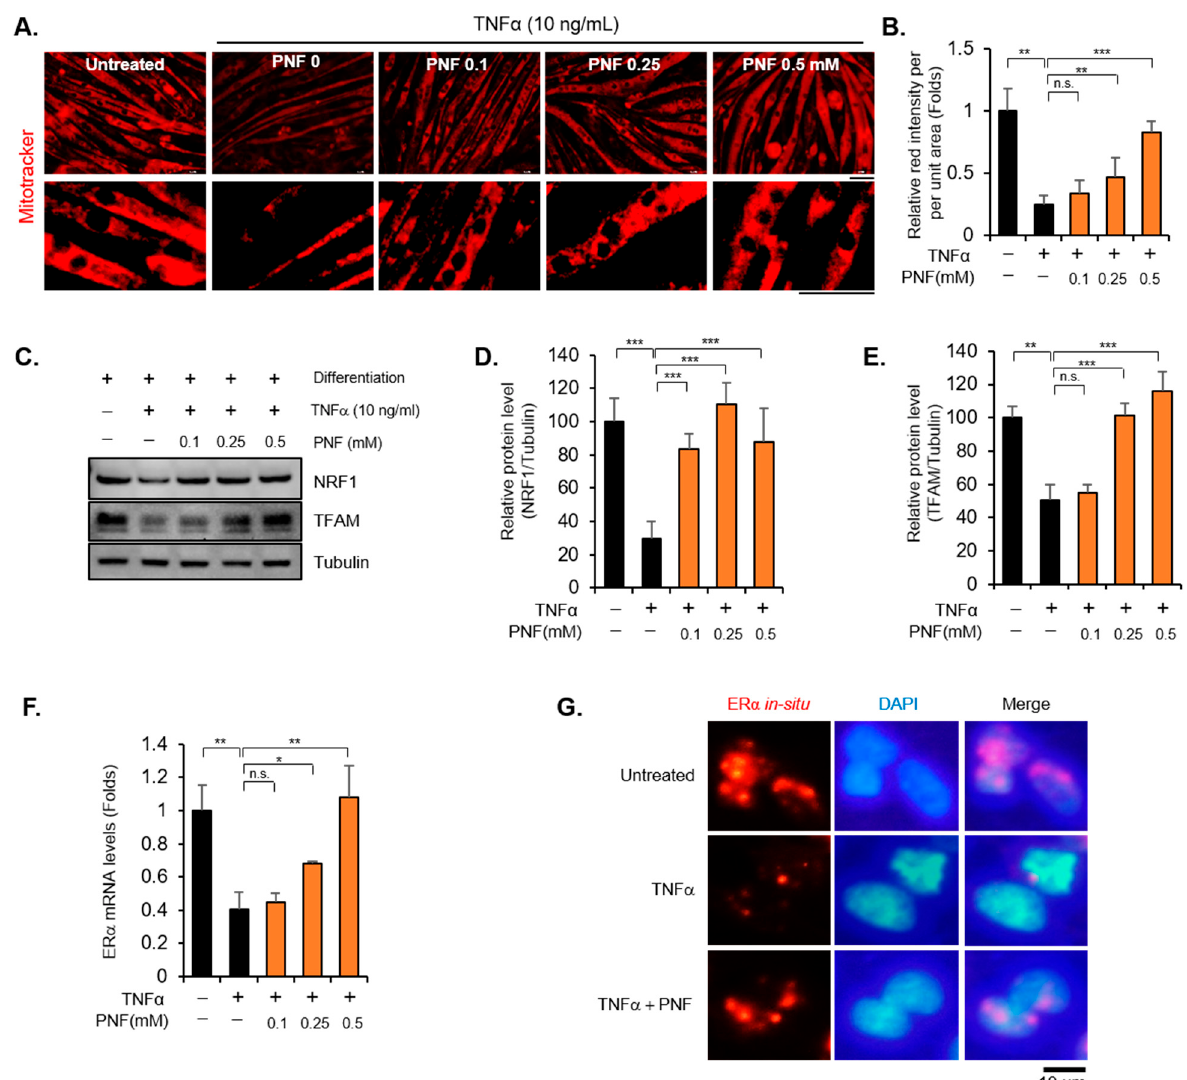
Figure 3. PNF restores mitochondrial biogenesis through NRF1, TFAM, and ER α in C2C12 cells: ( A ) Differentiated myoblasts were stained with MitoTracker. MitoTracker is shown in red. The scale bar indicates 50 µ m ( n = 5). ( B ) Intensity of MitoTracker was quantified in individual muscle cells ( n = 20 for each group). ( C ) Immunoblotting was performed on proteins extracted from differentiated muscle protein. Tubulin was used as an internal control. ( D , E ) Relative densitometric quantification of NRF1 and TFAM from three independent experiments after normalization to tubulin. Results are represented as the relative percentage levels. ( F ) Expression levels of ER α induced by TNF α (10 ng/mL) and PNF in C2C12 cells. ( G ) RNA in situ hybridization staining for ER α (red) and DAPI (blue) in C2C12 cells ( n = 5) * p < 0.05, ** p < 0.01, and *** p < 0.001. N.S., not